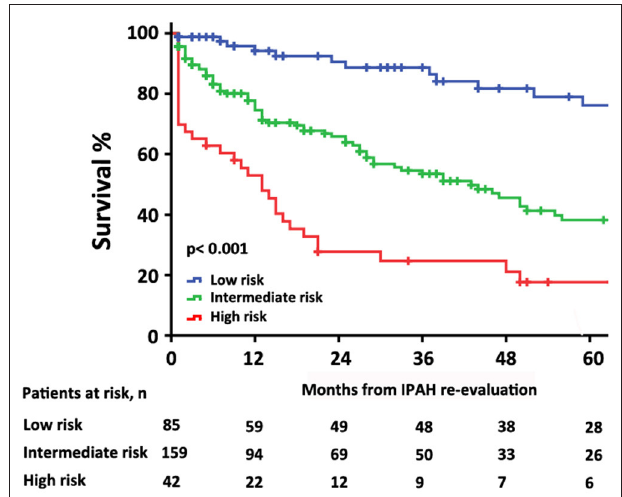
FIGURE 4 | Survival estimates in patients with idiopathic pulmonary arterial hypertension at re-evaluation according to the 2015 ESC/ERS risk stratification